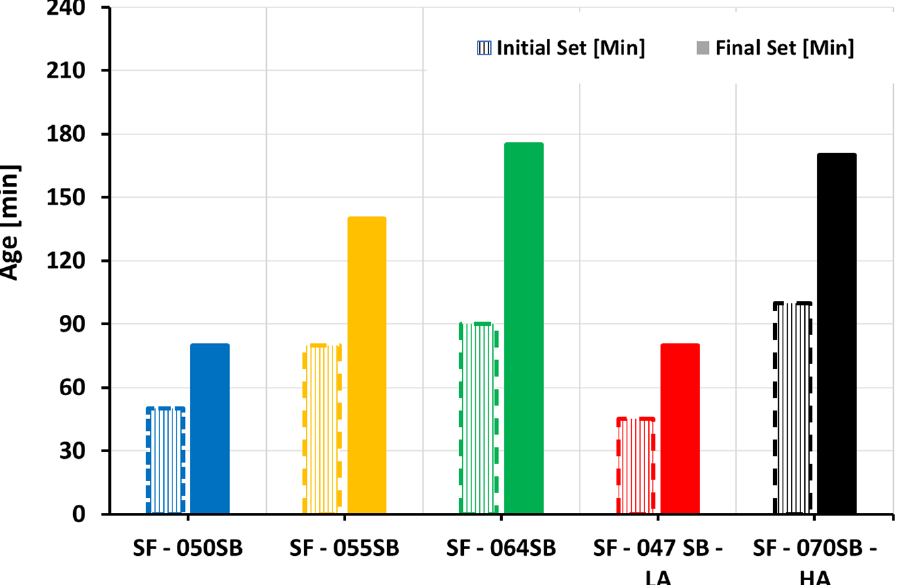
Figure 3. Initial and final setting times obtained from Vicat tests.